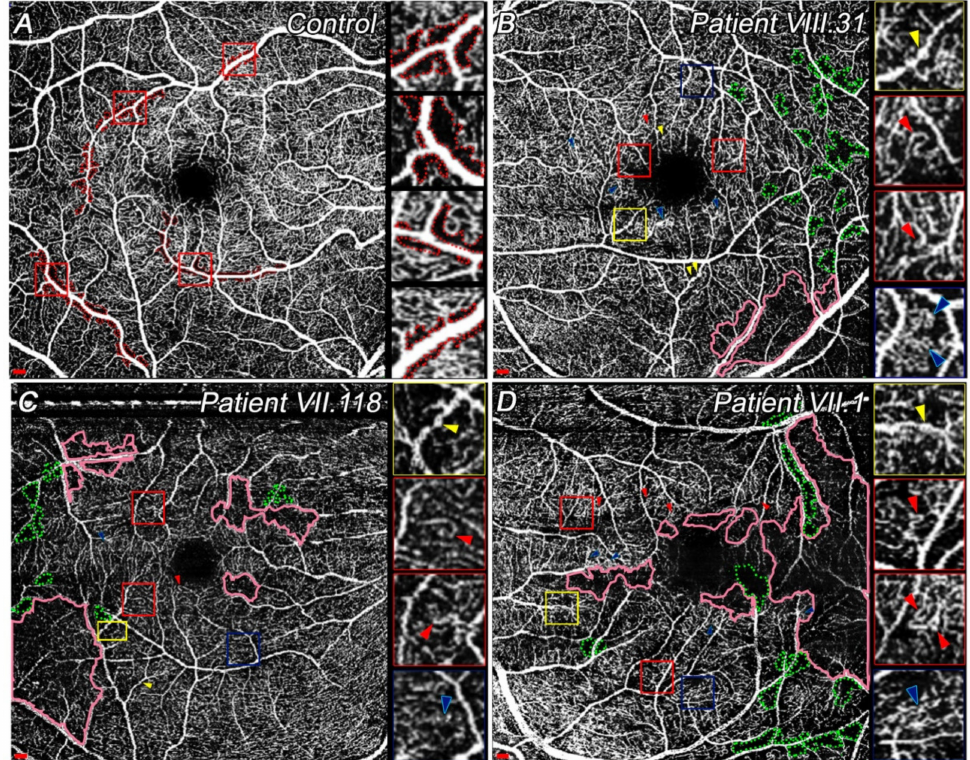
Figure 3. OCTA images of SVP centered at the macula in control and study patients. Insets at the right side of all images show different vascular signs in high magnification. ( A ) Superficial vessels of a healthy patient, showing capillary-free zone next to the large arteries (red dotted areas) and the FAZ, which is constituted by a single-layer of capillaries. Insets display several capillary-free zones. ( B ) Some slow blood flow areas (pink solid areas) and impaired perfusion areas (green dotted areas) already observed in addition to microaneurysms (yellow arrowheads), vascular loops or capillary bends (red arrowheads), and IRMAs (blue arrowheads) in patient VIII.31 (LE). ( C ) Similar signs to image ( B ) were detected in VII.118 (RE). ( D ) Larger slow blood flow areas (pink solid areas) and a greater number of capillary bends (red arrowheads) are shown. Capillary dropout areas (green dotted areas), microaneurysms (yellow arrowheads), and IRMAs (blue arrowheads) were also present in VII.1 (LE). Scale: 200 µ m. Abbreviations: superficial vascular plexus, SVP; left eye, LE; right eye, RE. Yellow squares show microaneurysms; red squares indicate capillary bends or vascular loops; blue squares show